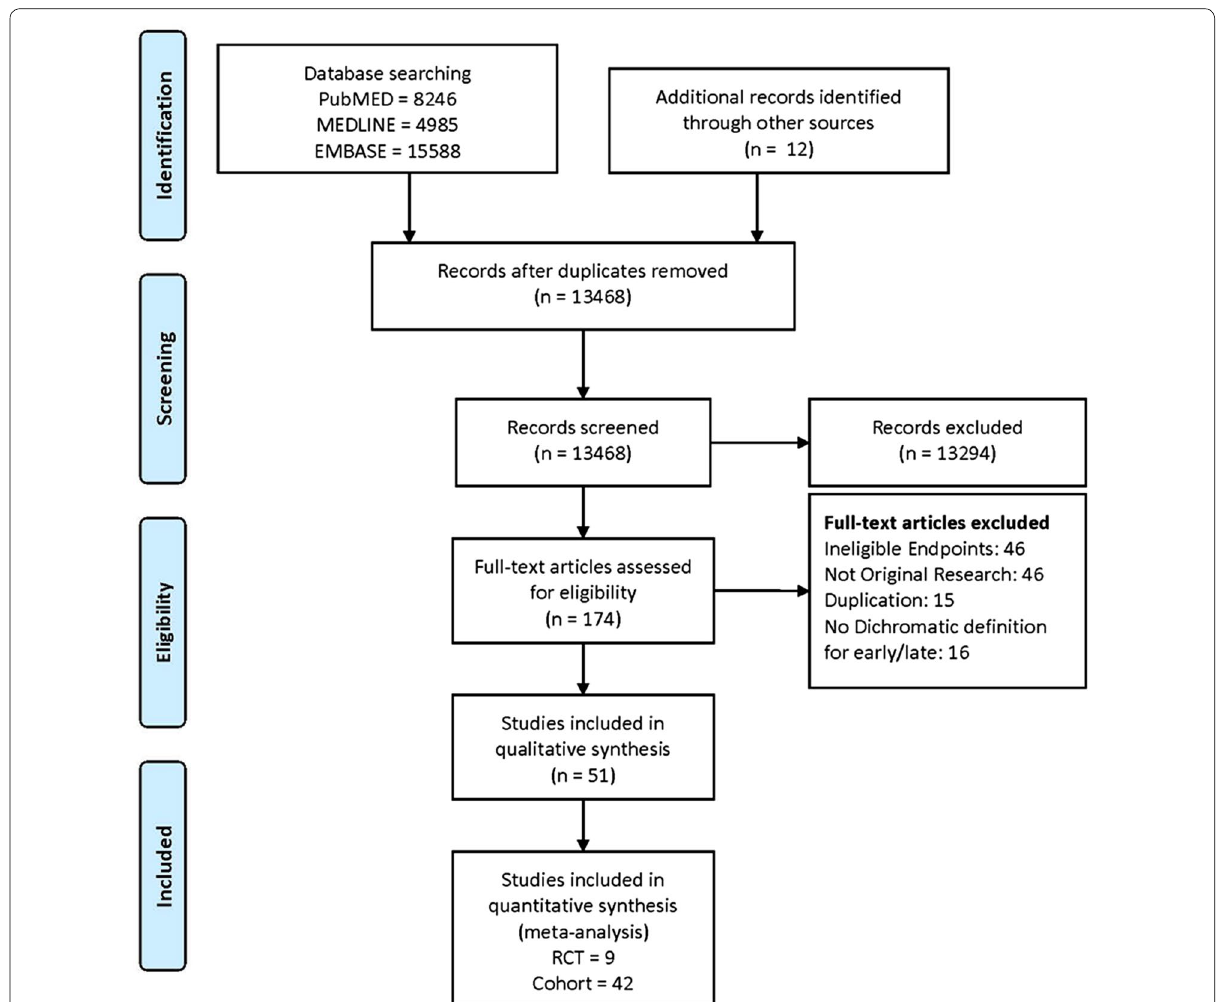
Fig. 1 Flowchart of study selection for meta‑analysis. RCT randomized controlled